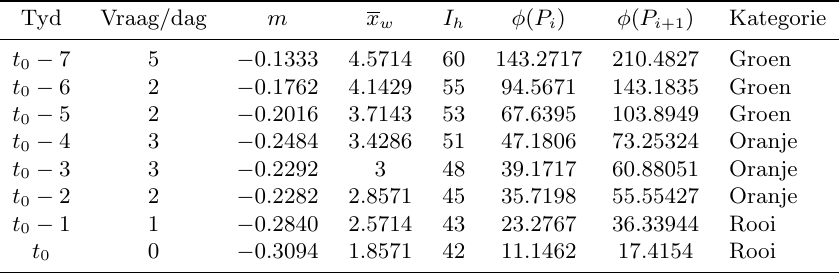
Tabel 4: Resultate vir Algoritme 1 ′ .